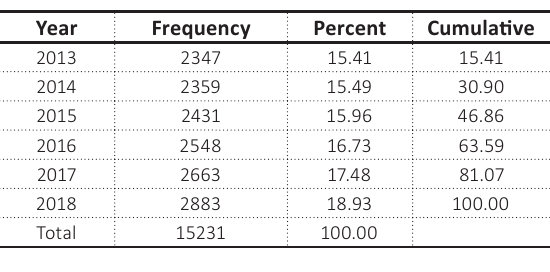
Table 4. Annual distribution of the